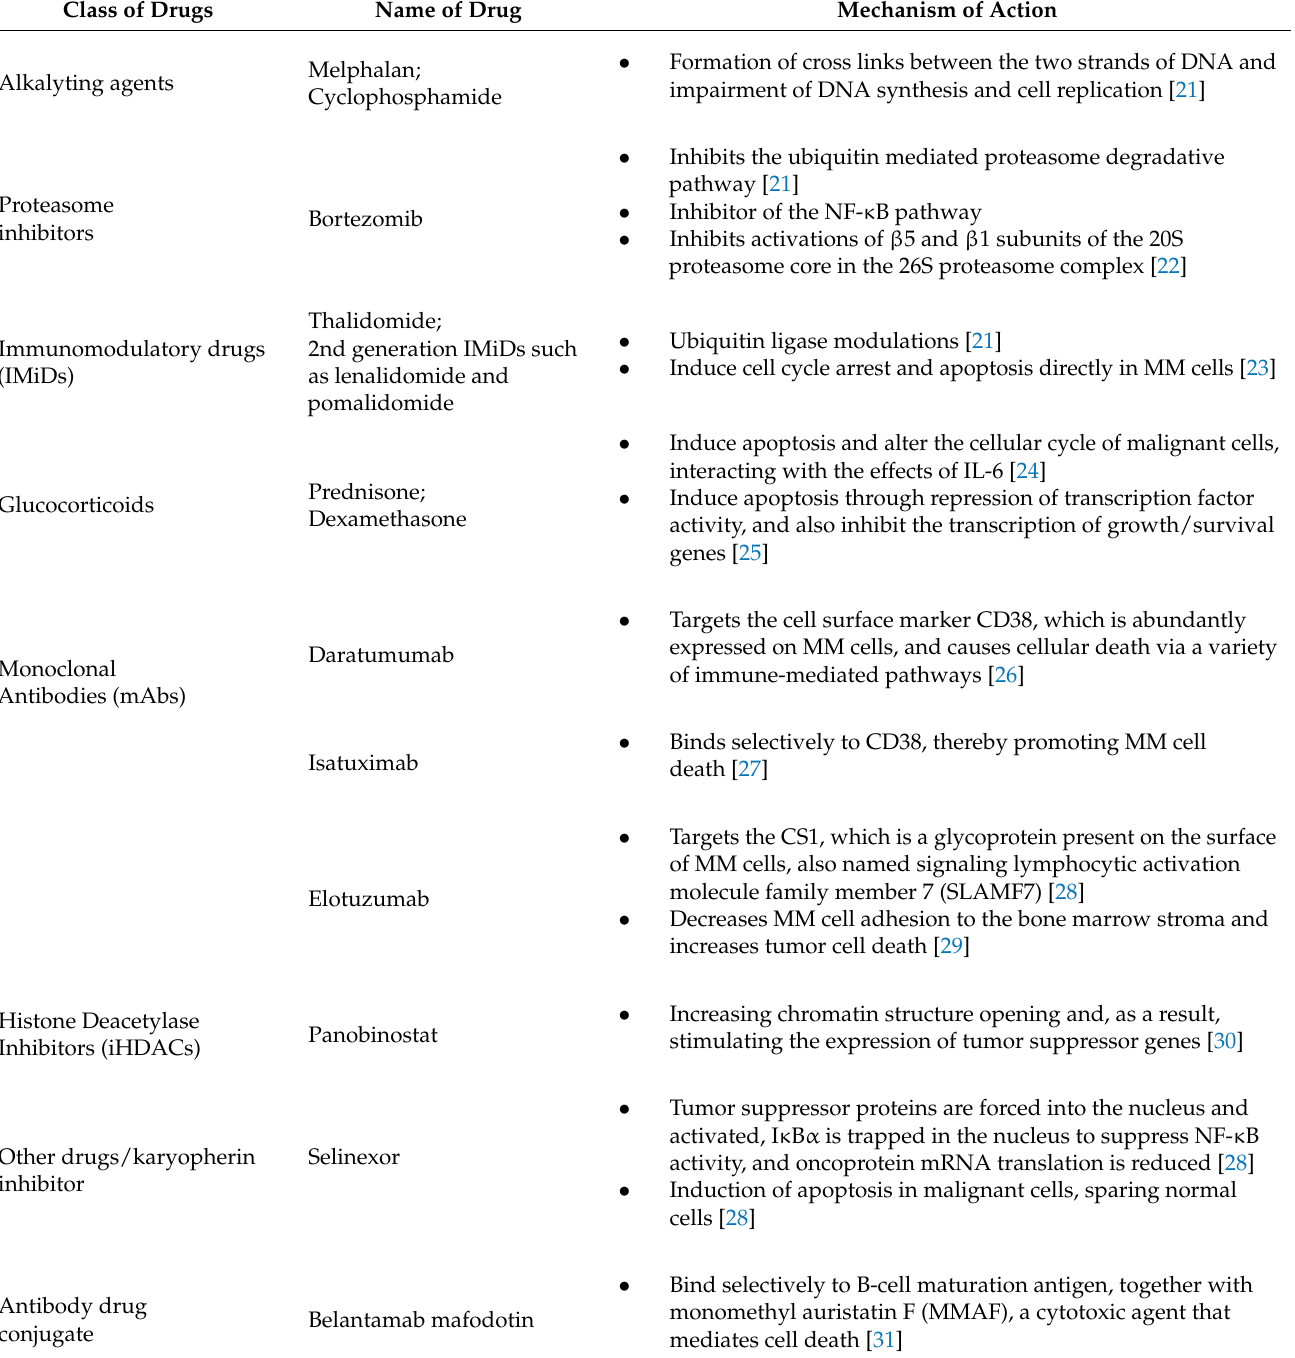
Table 1. Table showing different categories of drugs that are used to treat MM and their mechanisms of